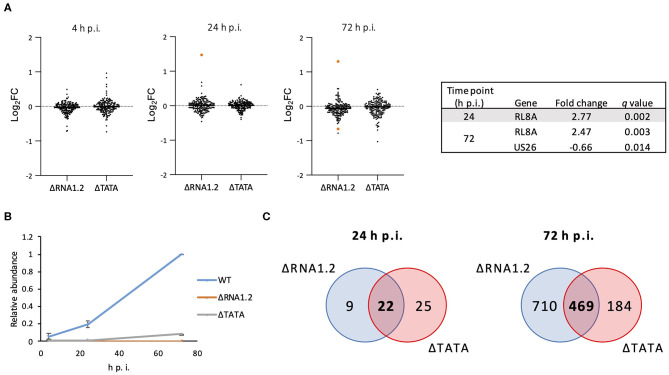
Dysregulation of viral and cellular transcripts in RNA1.2 mutant-infected cells. HFFF2 cells were infected with WT, ΔRNA1.2 or ΔTATA at MOI = 5. RNA was harvested at 4, 24, and 72 h p.i., and polyadenylated transcripts were subjected to transcriptomic analysis. The results of three independent experiments are shown. (A) Scatter plots showing expression of all viral genes in the mutant transcriptomes compared to the WT transcriptome. Changes are shown as log2 fold (log2FC) values. Transcripts that were significantly differentially expressed (q < 0.05) in the mutants are highlighted in orange and listed in the Table. (B) Graph showing RNA1.2 abundance in WT- and RNA1.2 mutant-infected cells at 4, 24 and 72 h p.i. Values for mutants are normalized to those for WT at 72 h p.i. Error bars denote standard deviation values. (C) Venn diagrams enumerating cellular transcripts that were significantly dysregulated in RNA1.2-infected cells (blue shading) and ΔTATA-infected cells (red shading) compared to WT-infected cells (q < 0.05). Dysregulated cellular mRNAs that are unique or common to ΔRNA1.2- and ΔTATA-infected cells are denoted by regular and bold font, respectively.